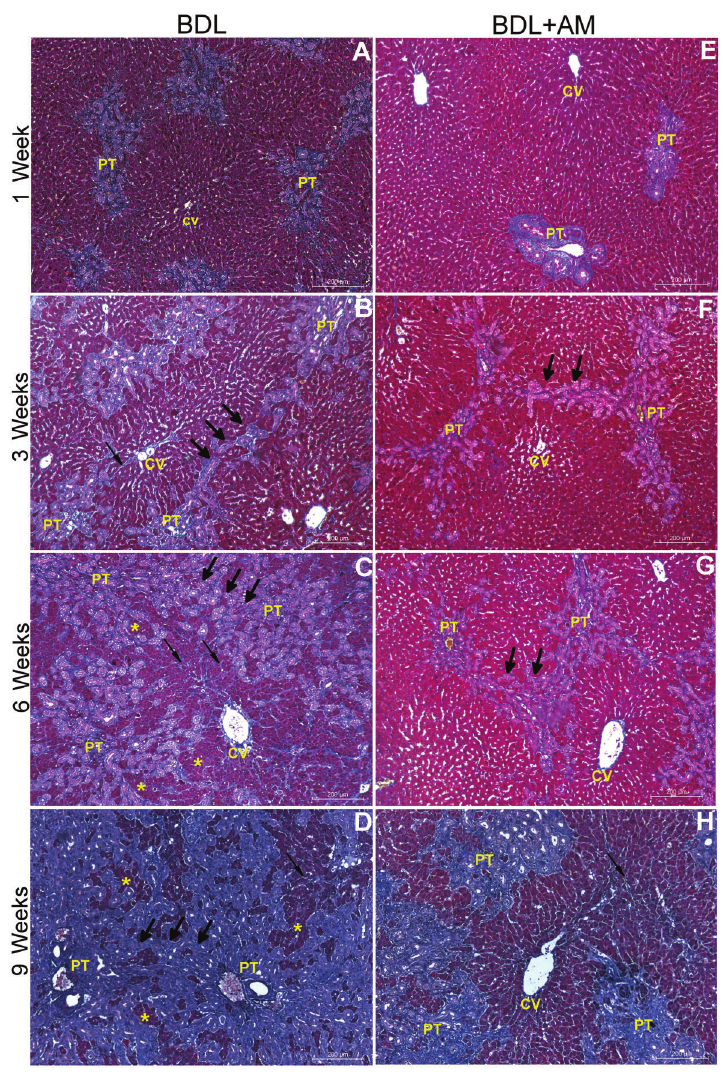
Figure 3. Representative microphotographs of liver fi brosis progression, in the experimental groups BDL (A – D) and BDL + AM (E – H), at 1, 3, 6, and 9 weeks after fi brosis induction. BDL: bile duct ligation; AM: amniotic membrane; CV: central vein; PT: portal tract with ductular expan- sion; thick arrows: connection ( fi brotic septa) between the expanded portal tracts; thin arrows: interstitial collagen fi bers in the hepatic parench- yma; *: nodules of hepatocytes. Masson ’ s trichrome staining with magni fi cation of 100 (cid:1)